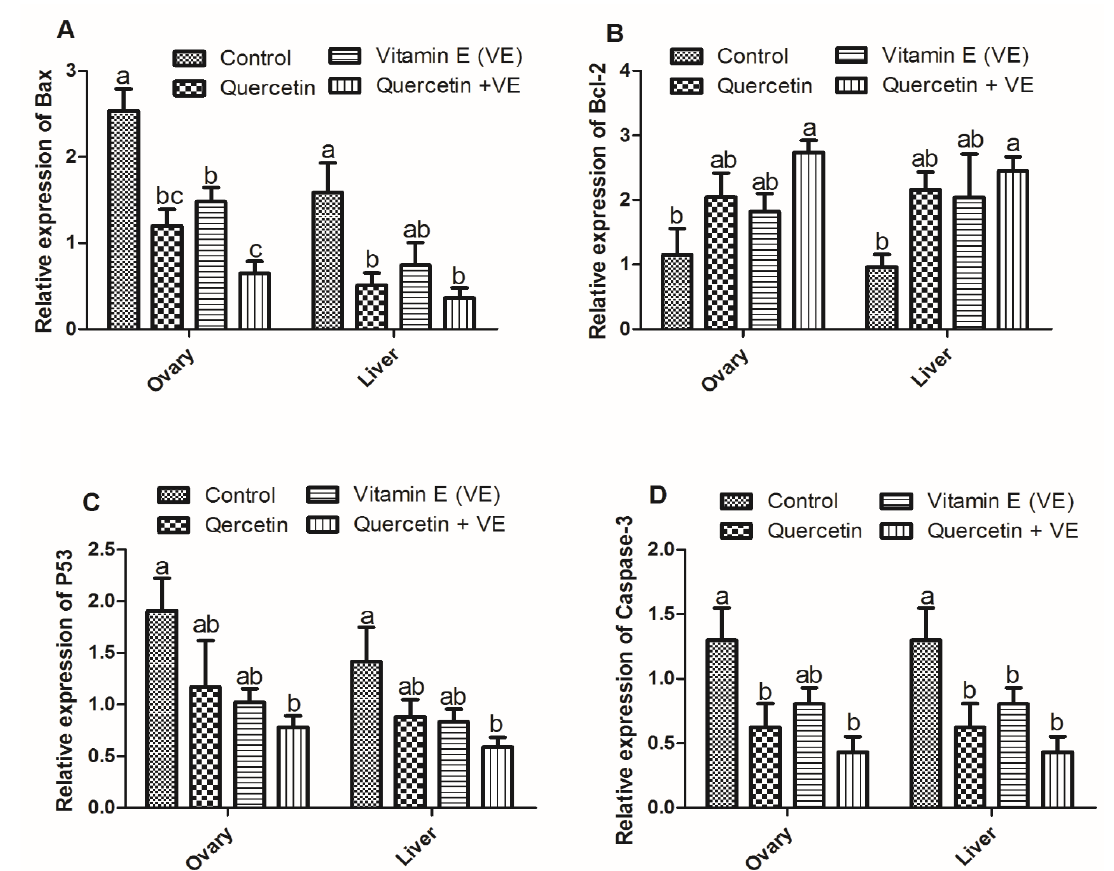
Figure 10. Effects of quercetin, vitamin E, and quercetin + vitamin E on the relative expression of apoptosis-related genes in the ovary and liver tissues. Levels of expression of Bax ( A ), Bcl-2 ( B ), p53 ( C ), and Caspase-3 ( D ). Bars without the same letter differed significantly ( p < 0.05).